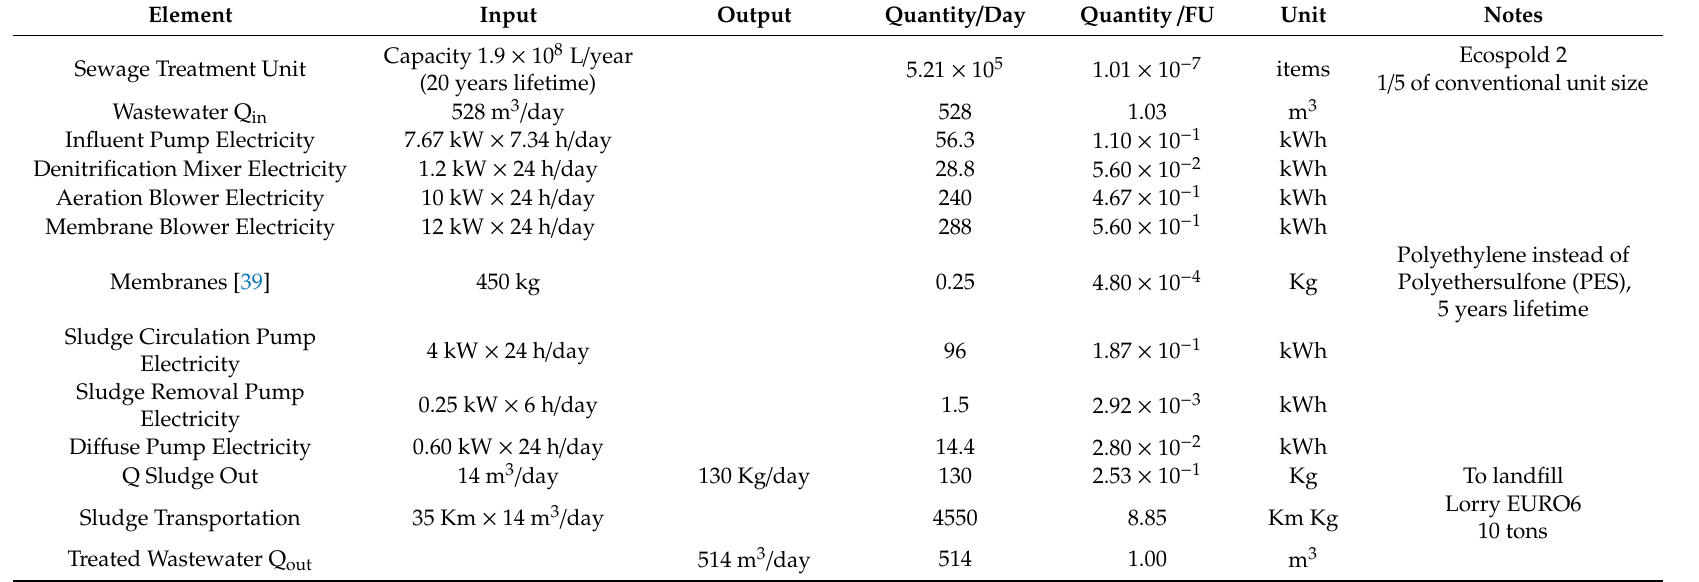
Table 1. Membrane bioreactor unit life cycle inventory